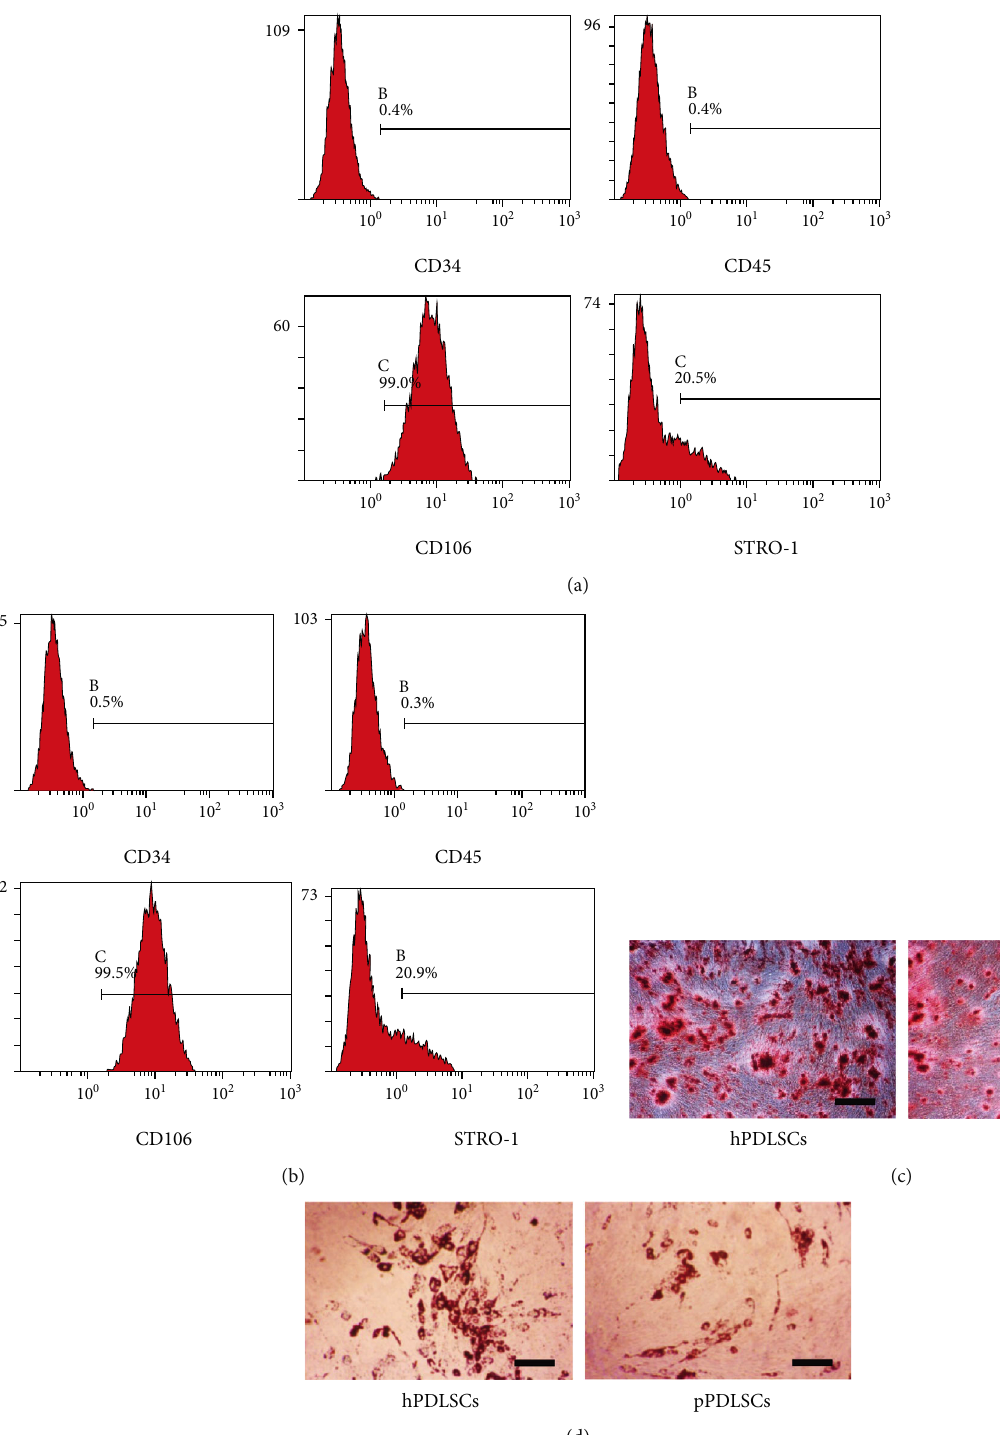
Figure 1: Identi fi cation of hPDLSCs and pPDLSCs. The surface markers of hPDLSCs (a) and pPDLSCs (b). Alizarin Red staining (c) and Oil red O staining (d) of hPDLSCs and